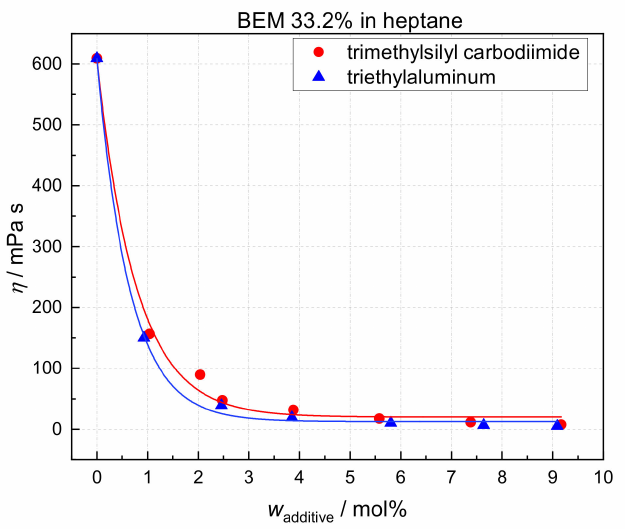
Figure 4. Viscosity profile of a 33.2% BEM solution in heptane with addition of different concentra- tions of the additives triethylaluminum (blue) and trimethylsilyl carbodiimide (red). The viscosity reduction by the addition of approx. 2.5 mol% additive was also tested for both alkyls in toluene (Table 2). The viscosity reduction effect is comparable to the effect in heptane but at a higher total viscosity level, since the intrinsic viscosity of the magnesium alkyls in toluene is higher. Table 2. Viscosities of BEM and BOMAG and the modified alkyls with triethylaluminum and silylcarbodiimide in the two solvents toluene and heptane. Additionally, the additive amount, alkyl concentration and aluminum content are listed.